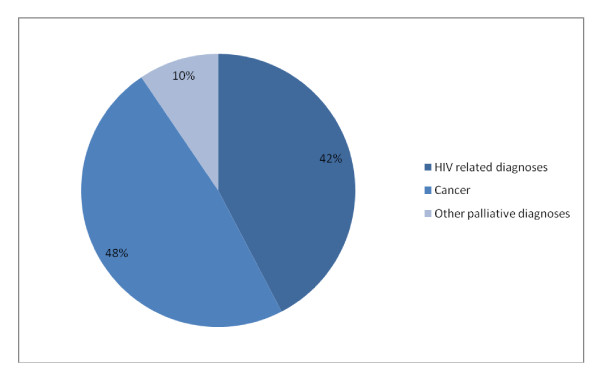
Patient diagnoses.